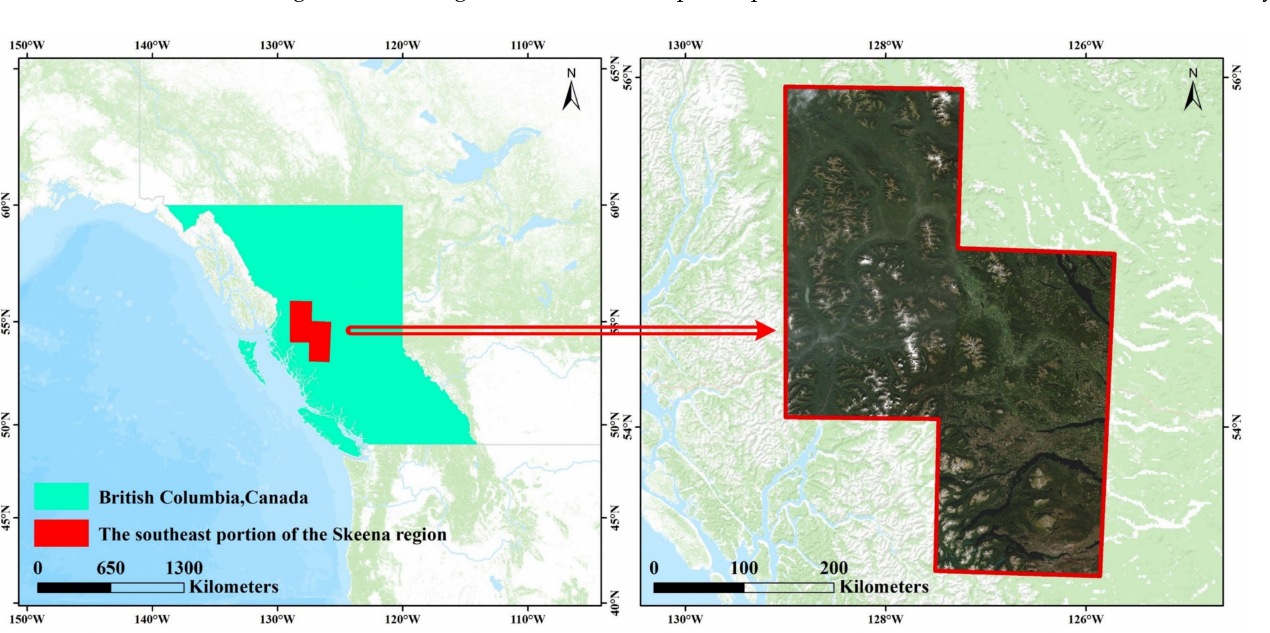
Figure 1. The study area’s location and an illustration of the Sentinel-2 images utilized for the experiment.